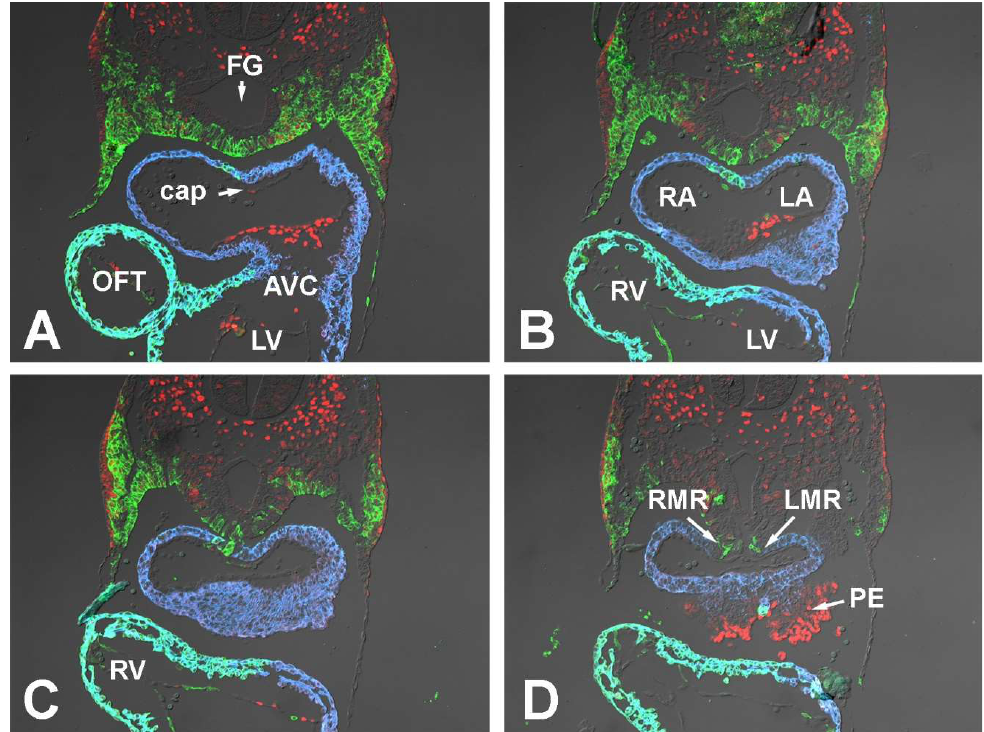
Figure 1. Sox9 expression at embryonic day 9.5. Panels ( A – D ) show serial sections of trans- versely sectioned SHFcre;R26mG embryos at ED9.5 immunofluorescently stained for the presence of Sox9 (red), Myosin Heavy Chain (blue), and GFP (green). The GFP staining delineates the SHF and SHF-derived cells. AVC = atrioventricular cushion, cap = mesenchymal cap, FG = foregut, PE = proepicardium, OFT = outflow tract, LA = left atrium, LMR = left mesocardial reflection, LV = left ventricle, RA = right atrium, RMR = right mesocardial reflection, RV = right